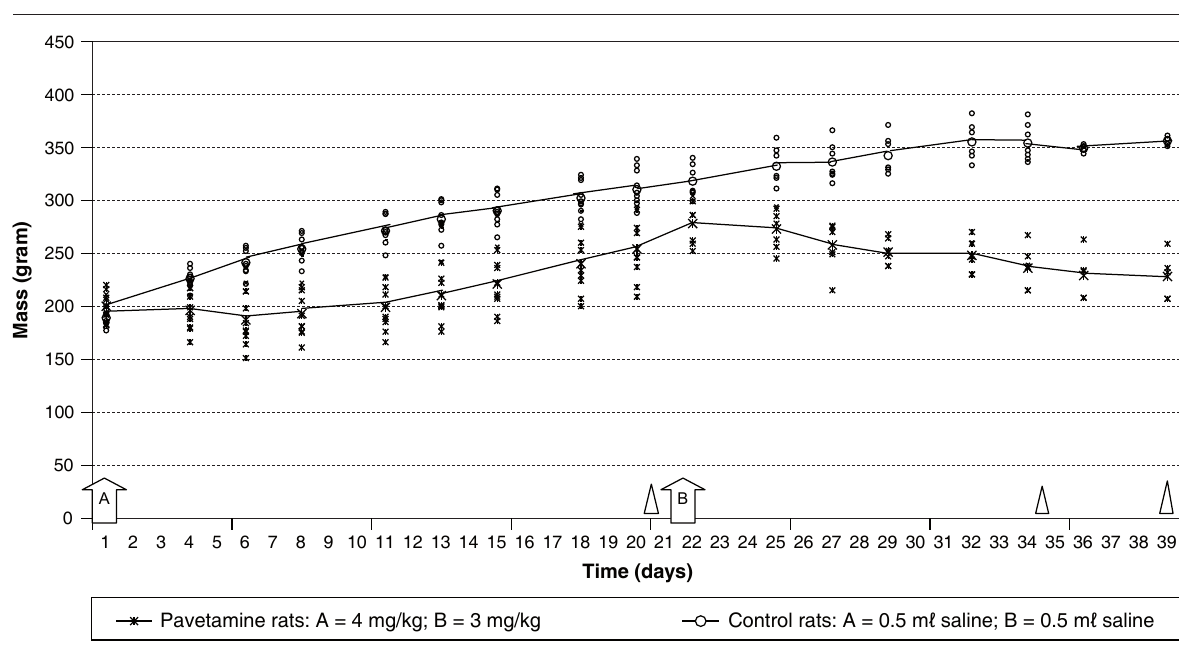
FIG. 1 The effects of pavetamine administration on rat body mass over a period of 39 TABLE 1 The cardiodynamic parameters of control rats and rats receiving pavetamine Control Pavetamine % Δ P ≤